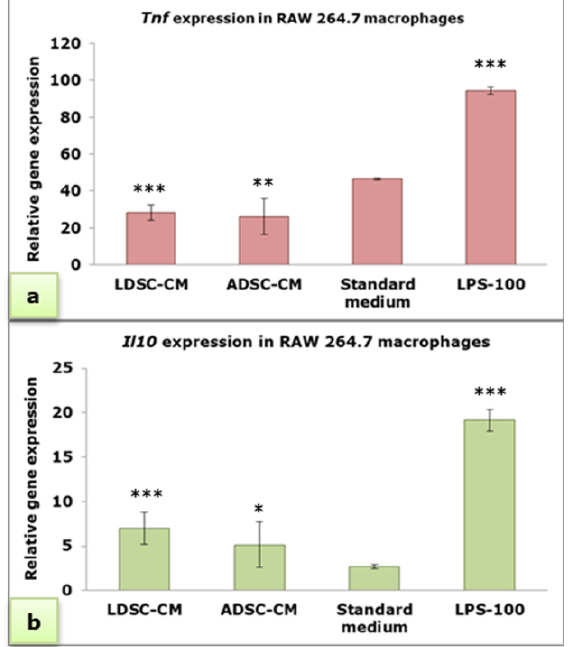
Figure 4. Morphology of RAW 264.7 macrophages cultured for 48 h in LDSC-CM ( a ), ADSC-CM ( b ), standard medium ( c ) and LPS-100 ( d ); phase contrast with objective magnification 20 × .